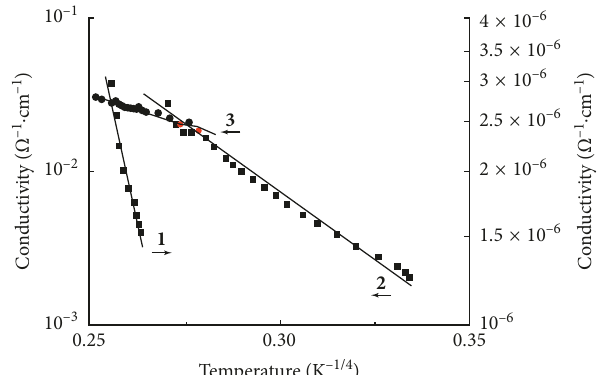
� 0 1 − x Ga x S 2 : x